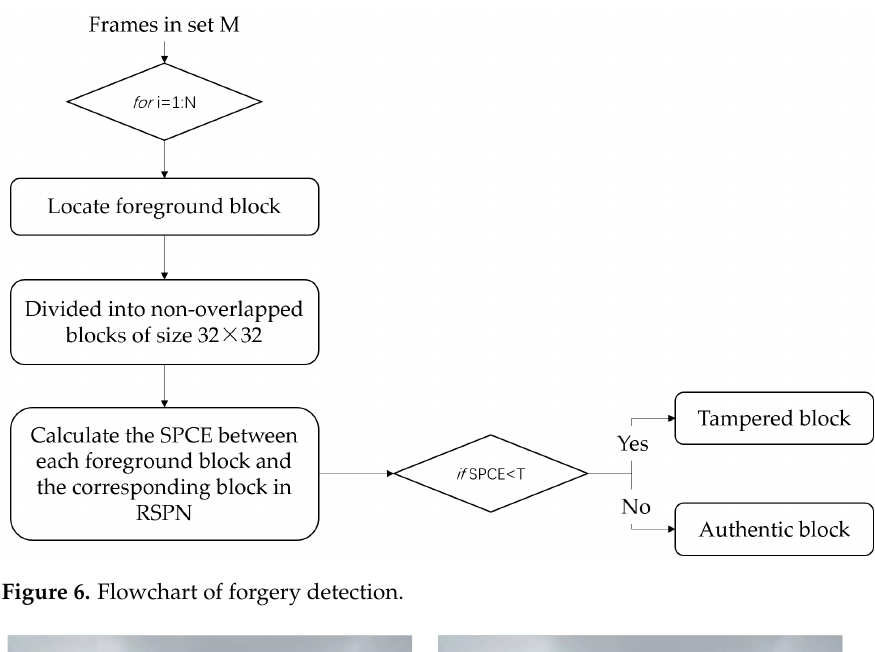
Figure 6. Flowchart of forgery detection.